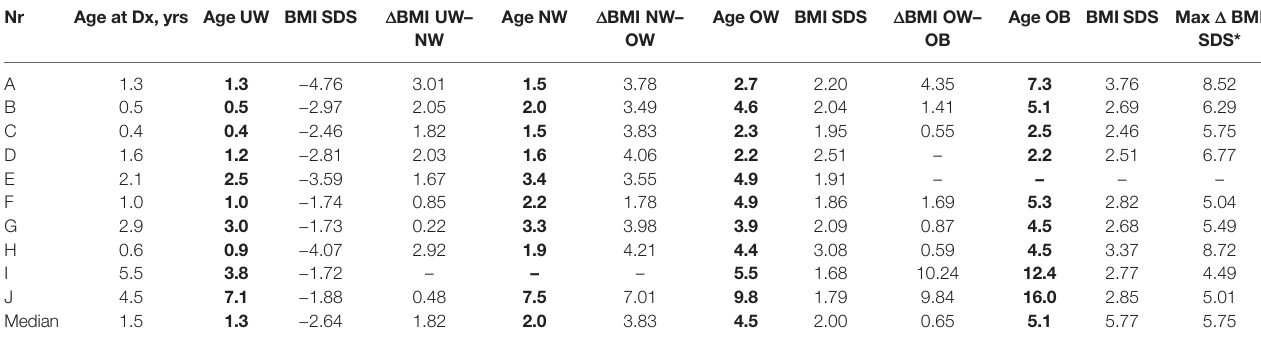
TABLE 2 | Change in BMI over time.